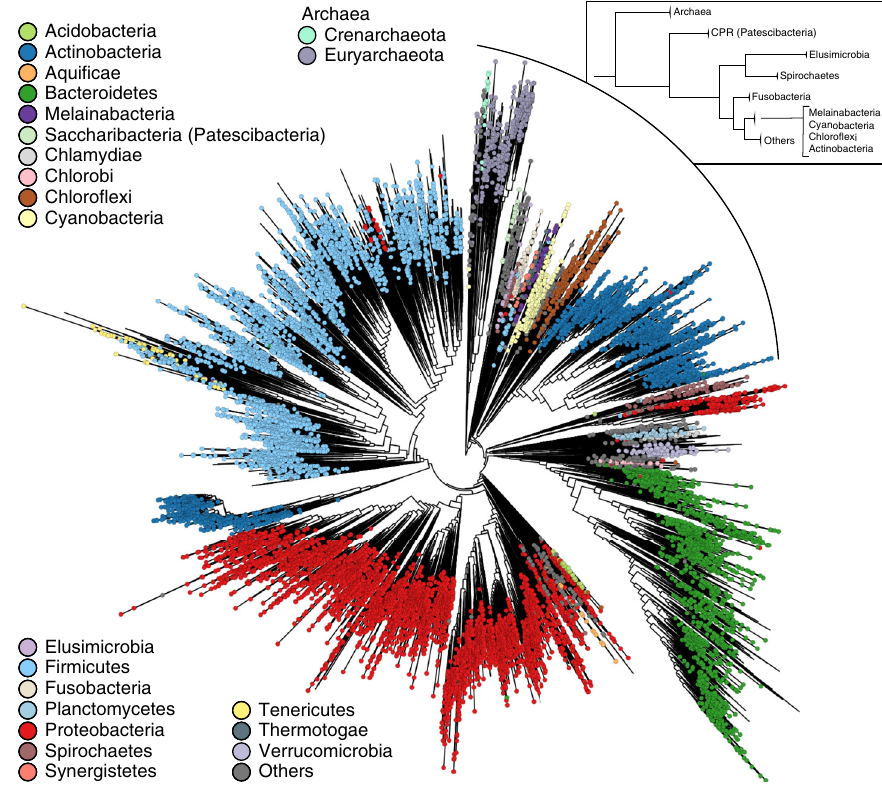
Fig. 4 PhyloPhlAn 3.0 microbial tree-of-life with 17,672 species-representative genomes from 51 known and 84 candidate phyla. With 17,672 species- dereplicated isolate genomes and MAGs as input (see “ Methods “ ), PhyloPhlAn 3.0 used 400 optimized universal marker sequences to produce a pan- microbial phylogeny in approximately 10 days (~24,000 CPU-hours on 100 parallel cores). The underlying multiple-sequence alignment comprised 4522 amino acid positions from among 1,872,710 in the untrimmed concatenated marker